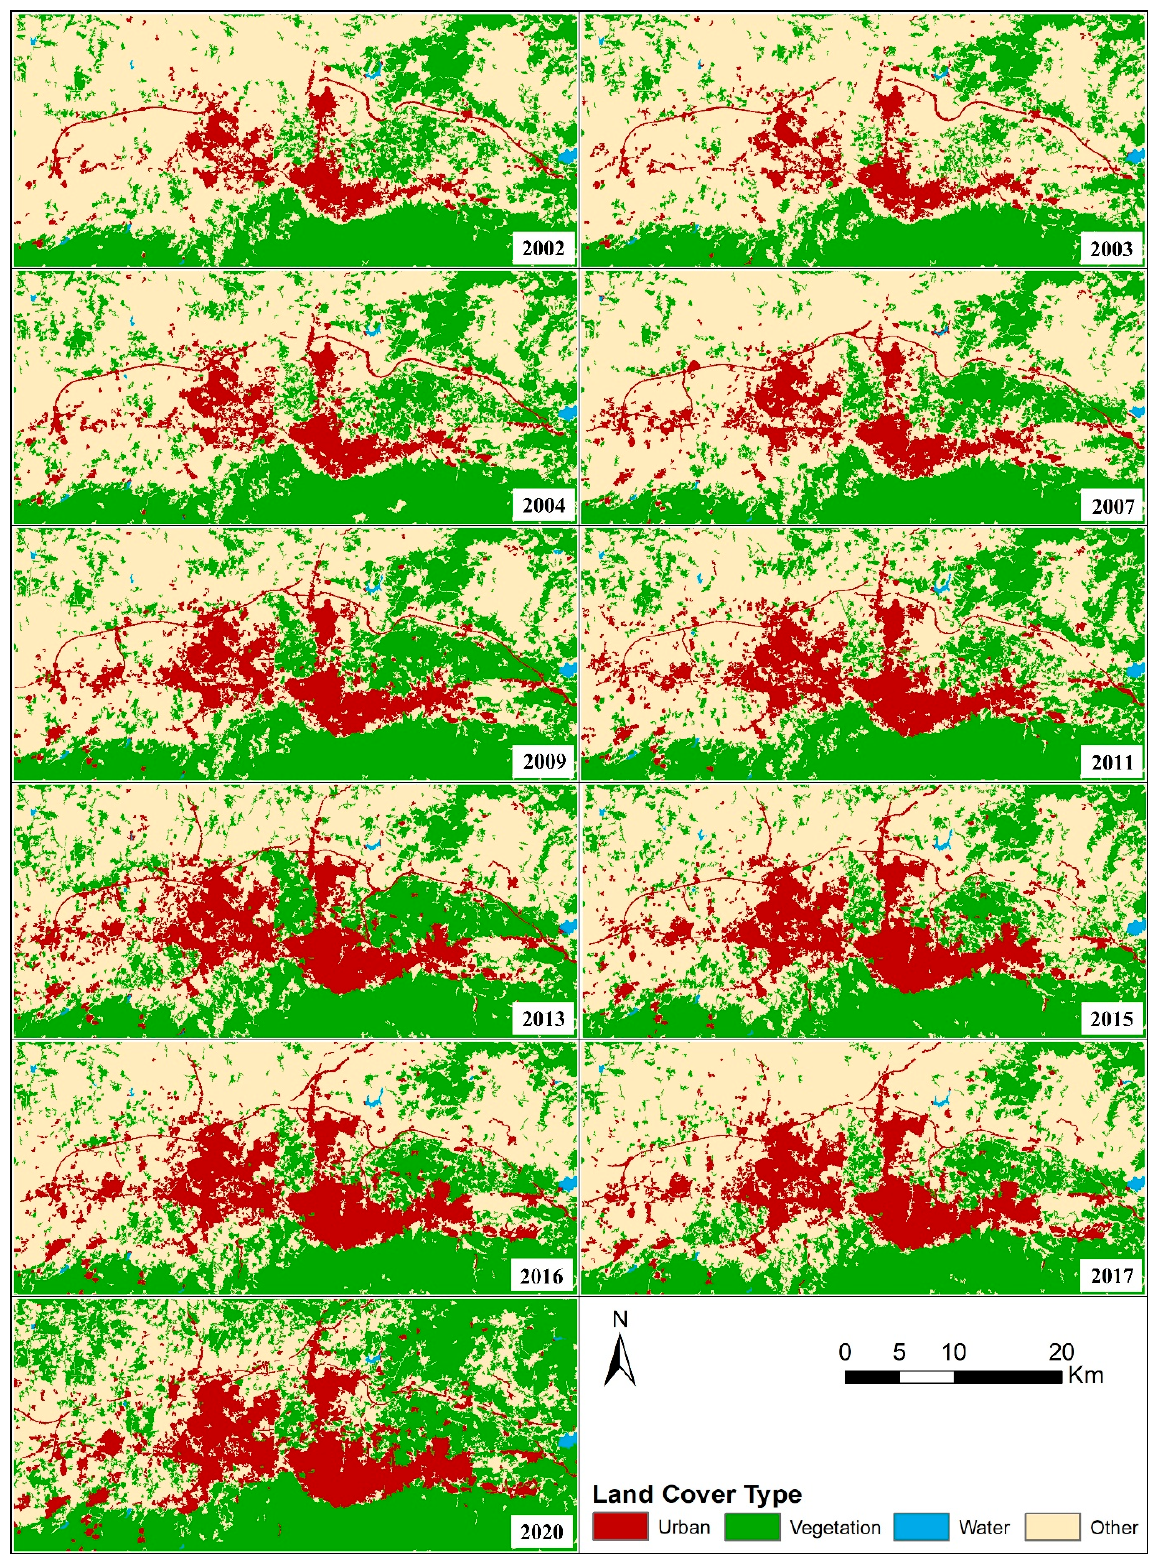
Figure 4. The obtained land cover classes using the index-based method for the years 2002, 2003, 2004, 2007, 2009, 2011,2013, 2015, 2016, 2017 and 2020.